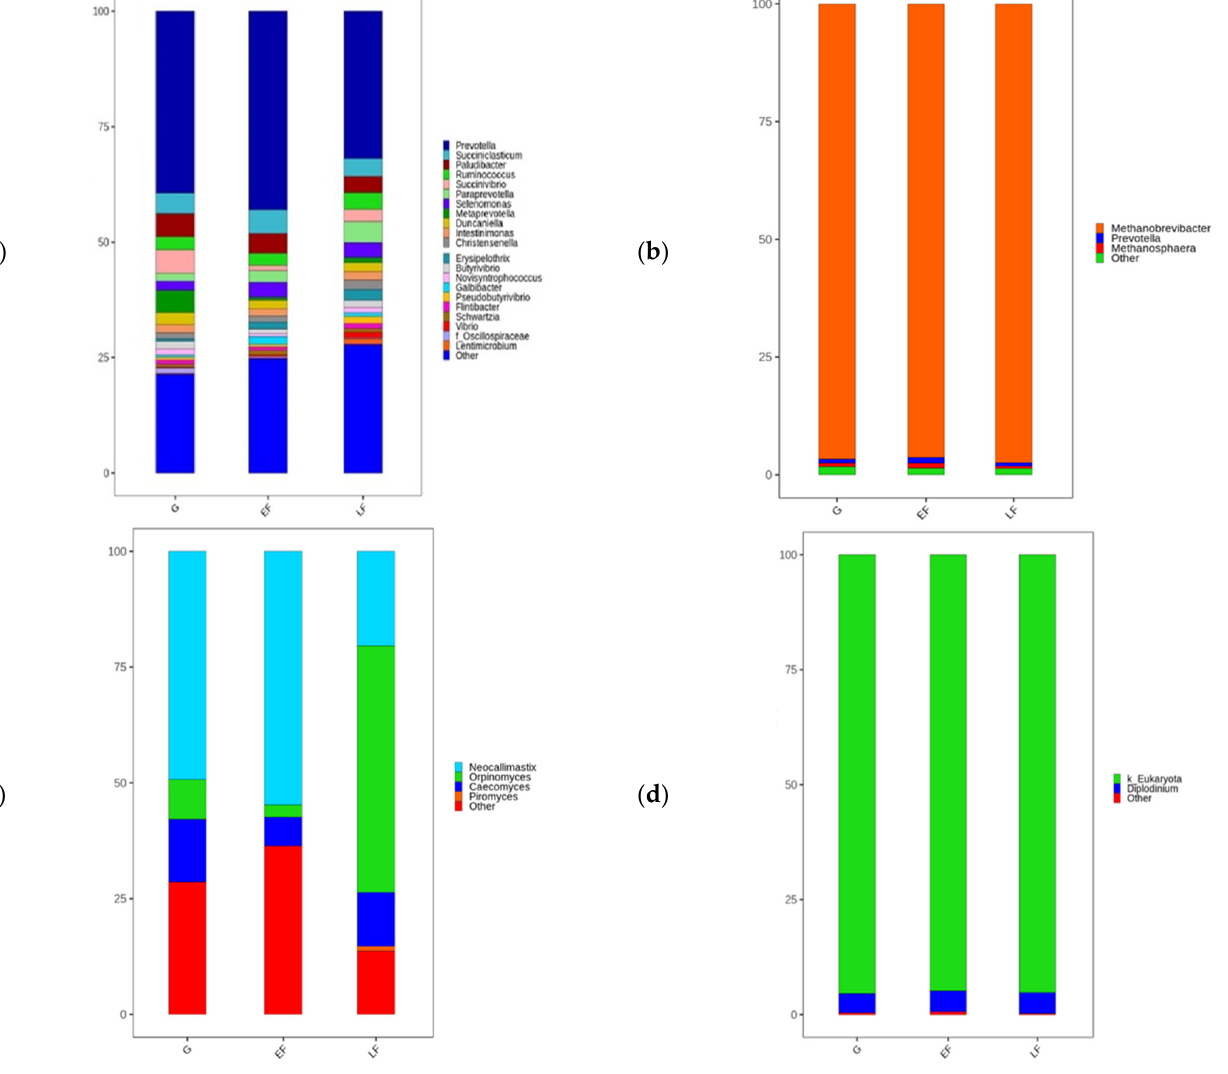
Figure 1. Relative abundance of rumen microbial diversity for the genus level from Hanwoo steers at different growth stages. Relative abundances of ( a ) bacterial genera, ( b ) archaeal genera, ( c ) fungal genera, and ( d ) protozoan genera are shown.